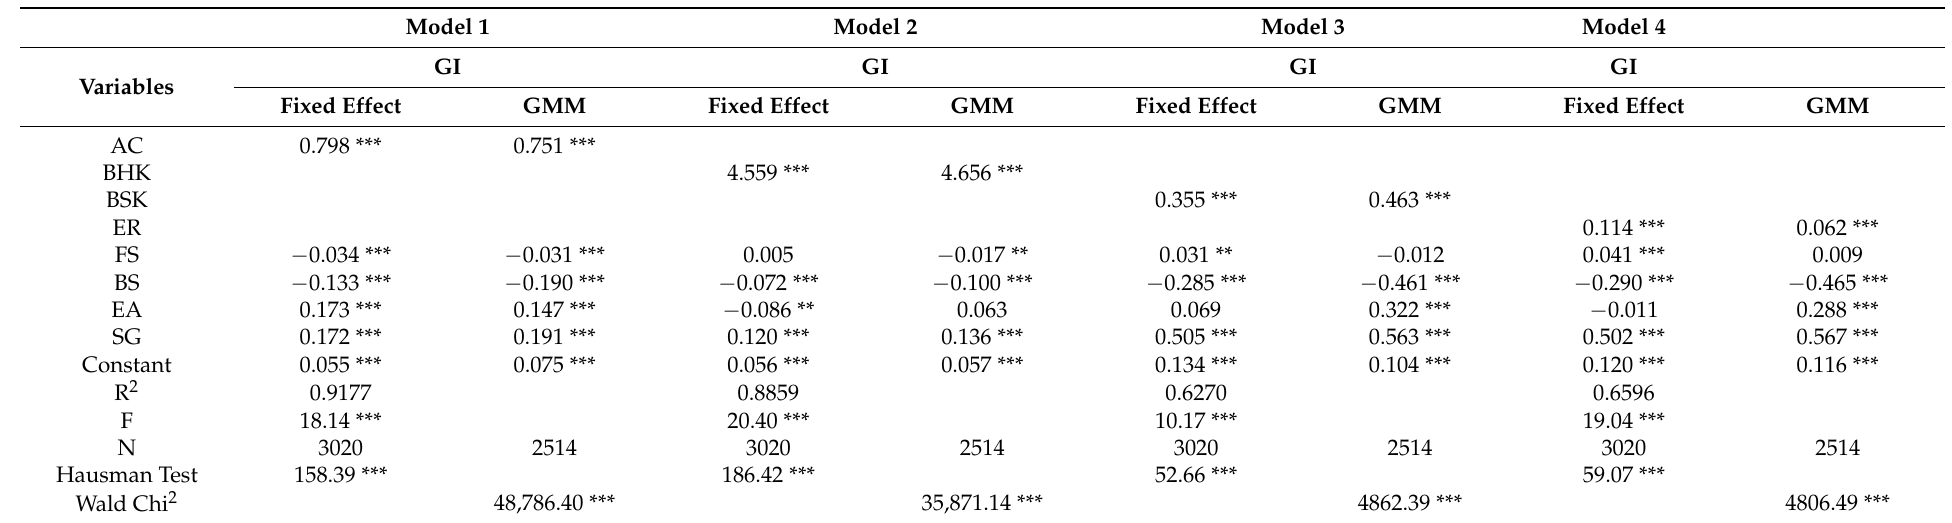
Table 2. The connection of AC, BHK, BSK, and ER with Green